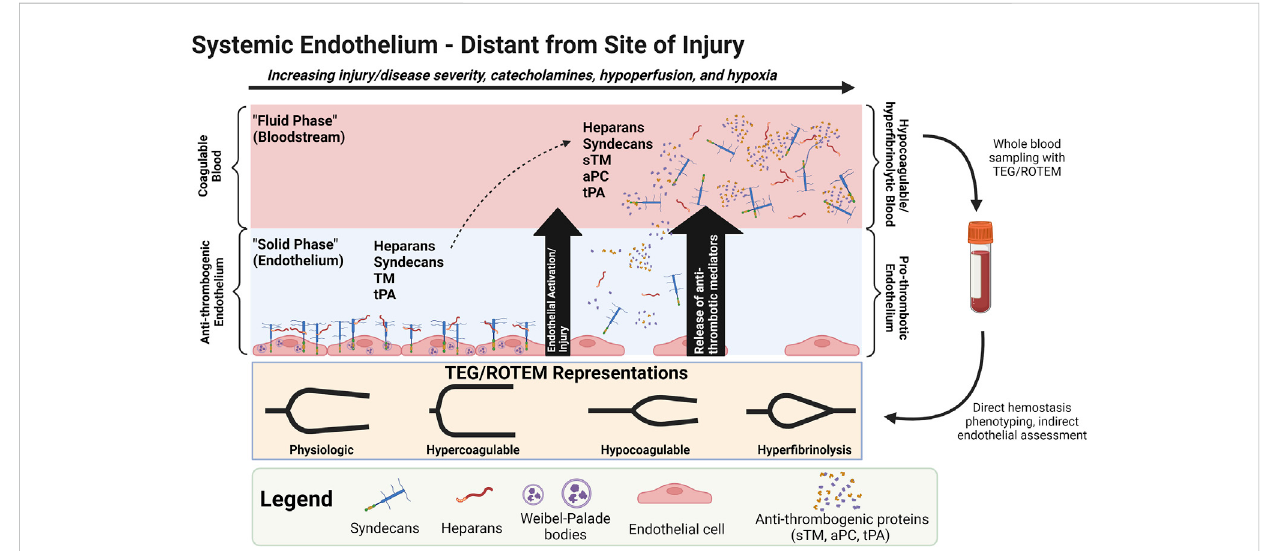
FIGURE 4 Shock-INduced Endotheliopathy (SHINE) “ Phenotype Switching ” via Release of Anti-thrombogenic Mediators from the Endothelium to the Bloodstream. One possible contributor of the hypocoagulable/hyper fi brinolytic phenotype in progressive shock may be the release of physiologically endothelial-sequestered anti-thrombogenic mediators to thebloodstream during SHINE when the endothelium is systemically activated and/or injured. Note that protein C is physiologically a plasma protein, but increases in soluble thrombomodulin (sTM) may increase the conversion of protein C to activated protein C (aPC). (Johansson and Ostrowski, 2010). Abbreviations: aPC, activated Protein C; ROTEM, Rotational Thromboelastometry; sTM, soluble Thrombomodulin; TEG, Thromboelastography; tPA, tissue Plasminogen Activator. Created with